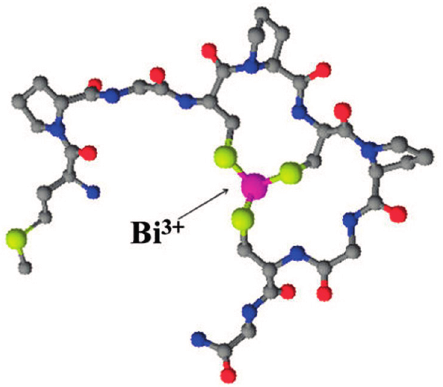
Figure 3. Proposed structures of BiL complex; L is the N-terminus of ZIP13 (MPGCPCPGCG-NH 2 ). Hydrogens were removed for clarity; colours: grey, carbon; blue, nitrogen; red, oxygen; yellow, sulphur [29]. Reproduced with permission from [29]. Copyright (2011) American Chemical Society.